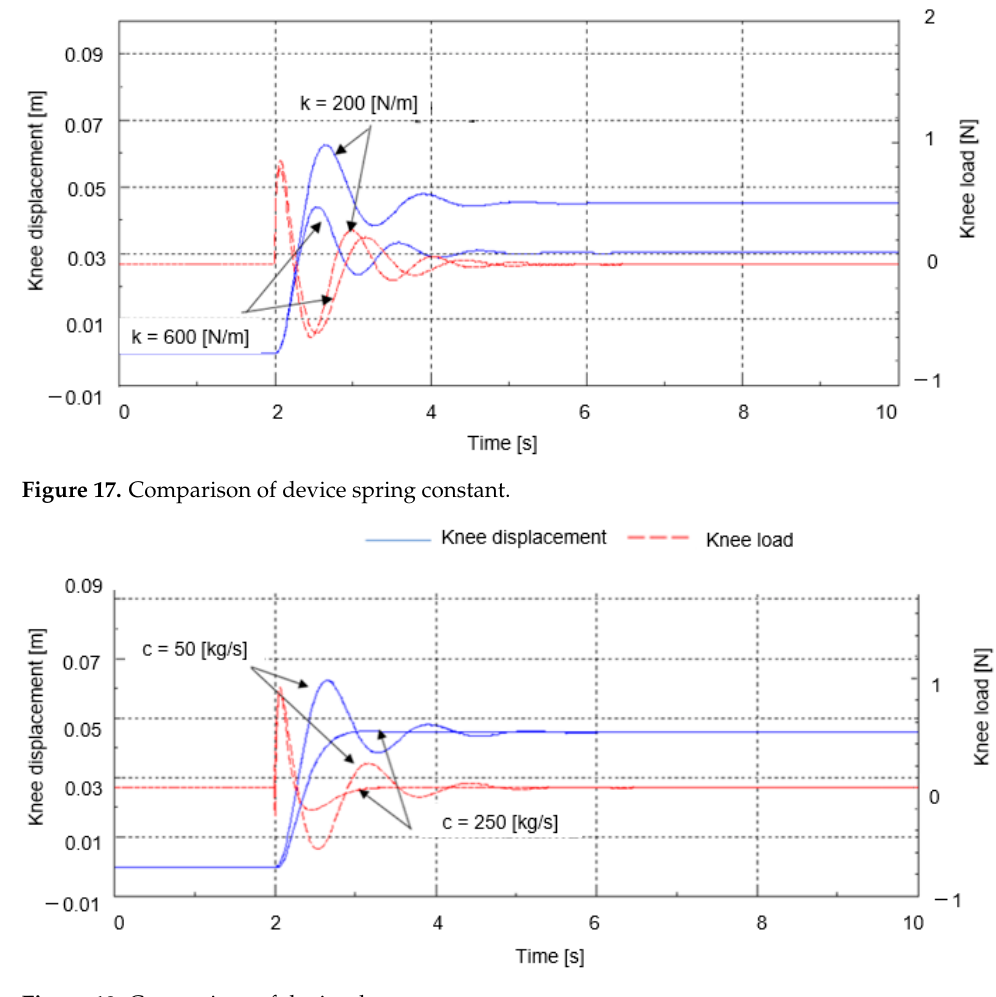
Figure 18. Comparison of device dumper constant.